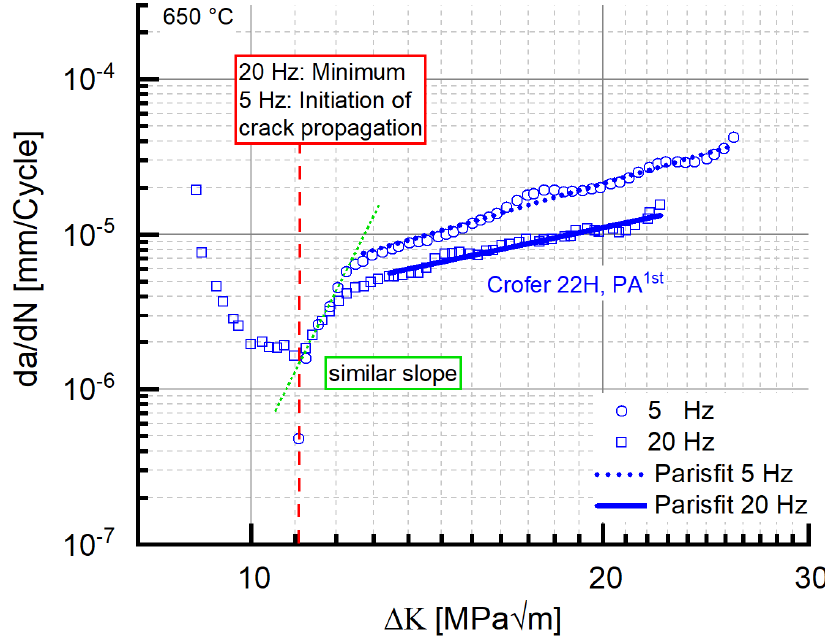
Figure 15. “Frequency impact” on crack propagation rate and corresponding Paris fits in precipitation- annealed Crofer ® 22H (PA) at 650 °C. Table 6. “Frequency dependent” fatigue crack growth parameters in precipitation-annealed Crofer ® 22H (PA) at 650 °C.